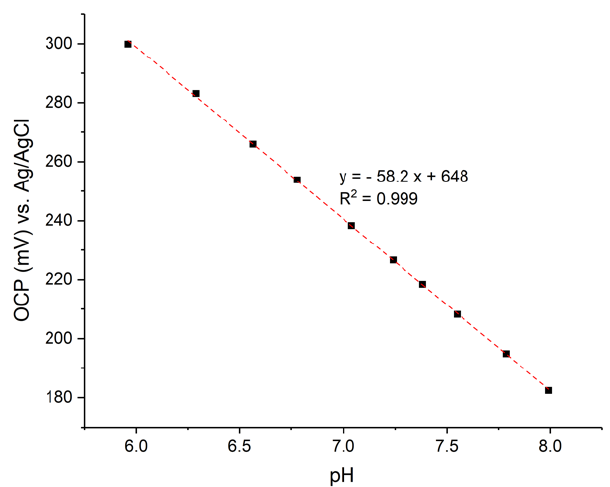
Figure 3. Open-circuit potential of (preconditioned) RuOx electrode in isotonic PBS buffer with a pH range of 6–8. Dashed line is linear fitting through the points.